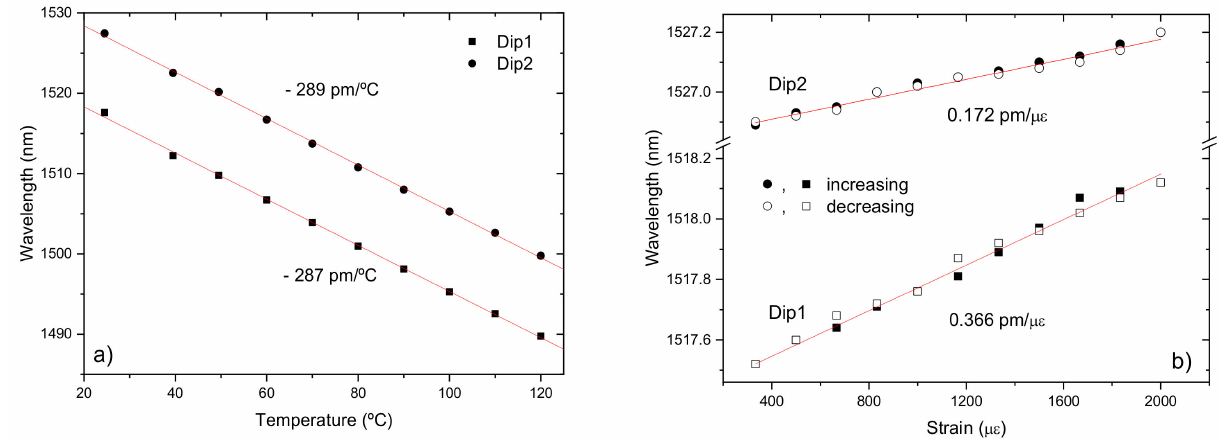
Figure 22. ( a ) Temperature and ( b ) strain sensitivities. Reprinted with permission from [113]. © 2021 The Optical